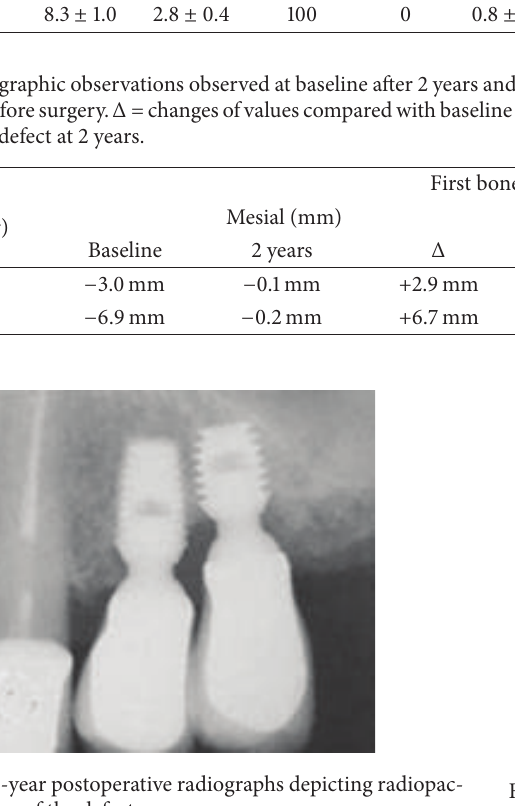
Figure 14: Two-year postoperative clinical examination revealed health hard and soft tissues with no bleeding and reduced probing depth (buccal and lingual/palatal probing